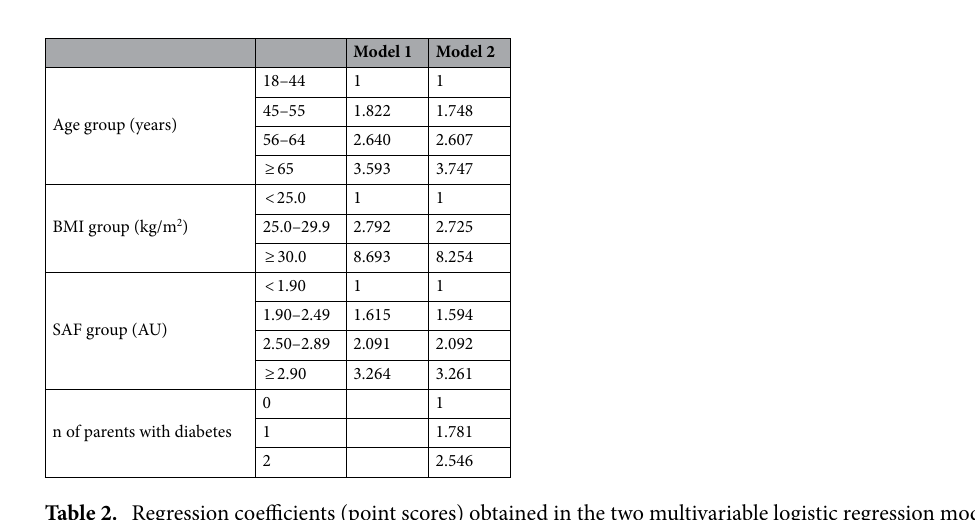
Table 2. Regression coefficients (point scores) obtained in the two multivariable logistic regression models. AU arbitrary units, BMI body mass index, SAF skin